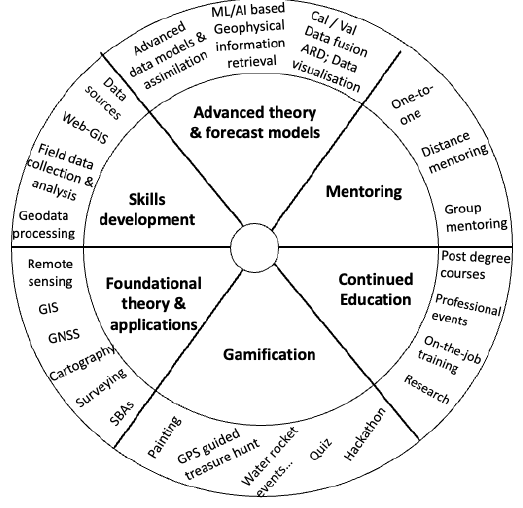
Figure 2 . GSTA learning wheel.